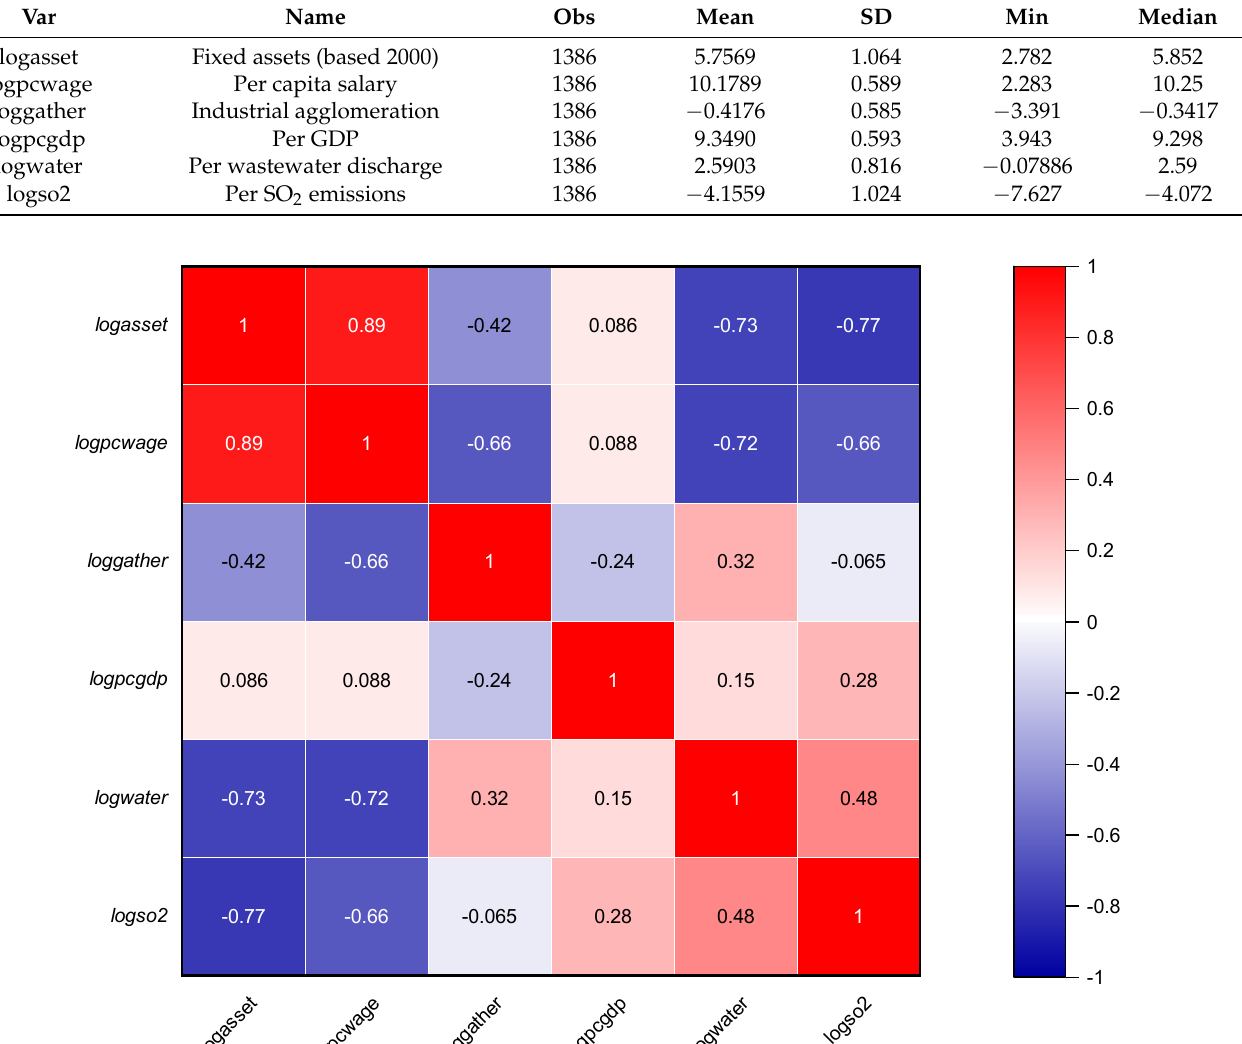
Table 1. The summary statistics.